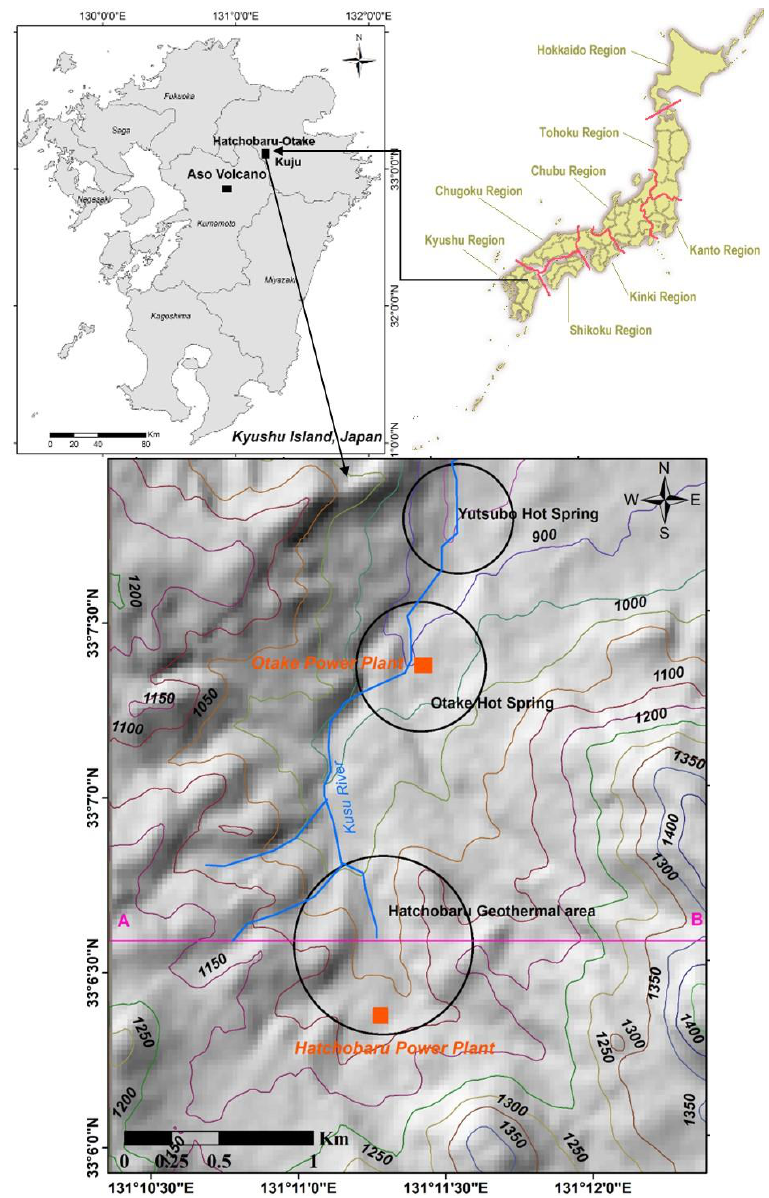
Figure 1. Location of the Hatchobaru–Otake (HO) geothermal area. Background (hillshade) and contours (elevation in meters above mean sea level), prepared using Shuttle Radar Topography Mission digital elevation model values. Our study area was about 12 km 2 . The profile ‘A–B’ was used to compare the land surface temperature, radiative heat flux, and normalized difference vegetation index values of the study area. Heat loss was also monitored separately for the Hatchobaru and Otake geothermal area, shown as circles. The Aso-san meteorological station (AMeDAS, Automated Meteorological Data Acquisition System) is located near the crater of the Aso volcano, about 27 km southwest of the study area (32°52.8′N and 131°04.4′E; altitude is about 1142.3 m above mean sea level), shown with a rectangle in the index map of Kyushu Island.